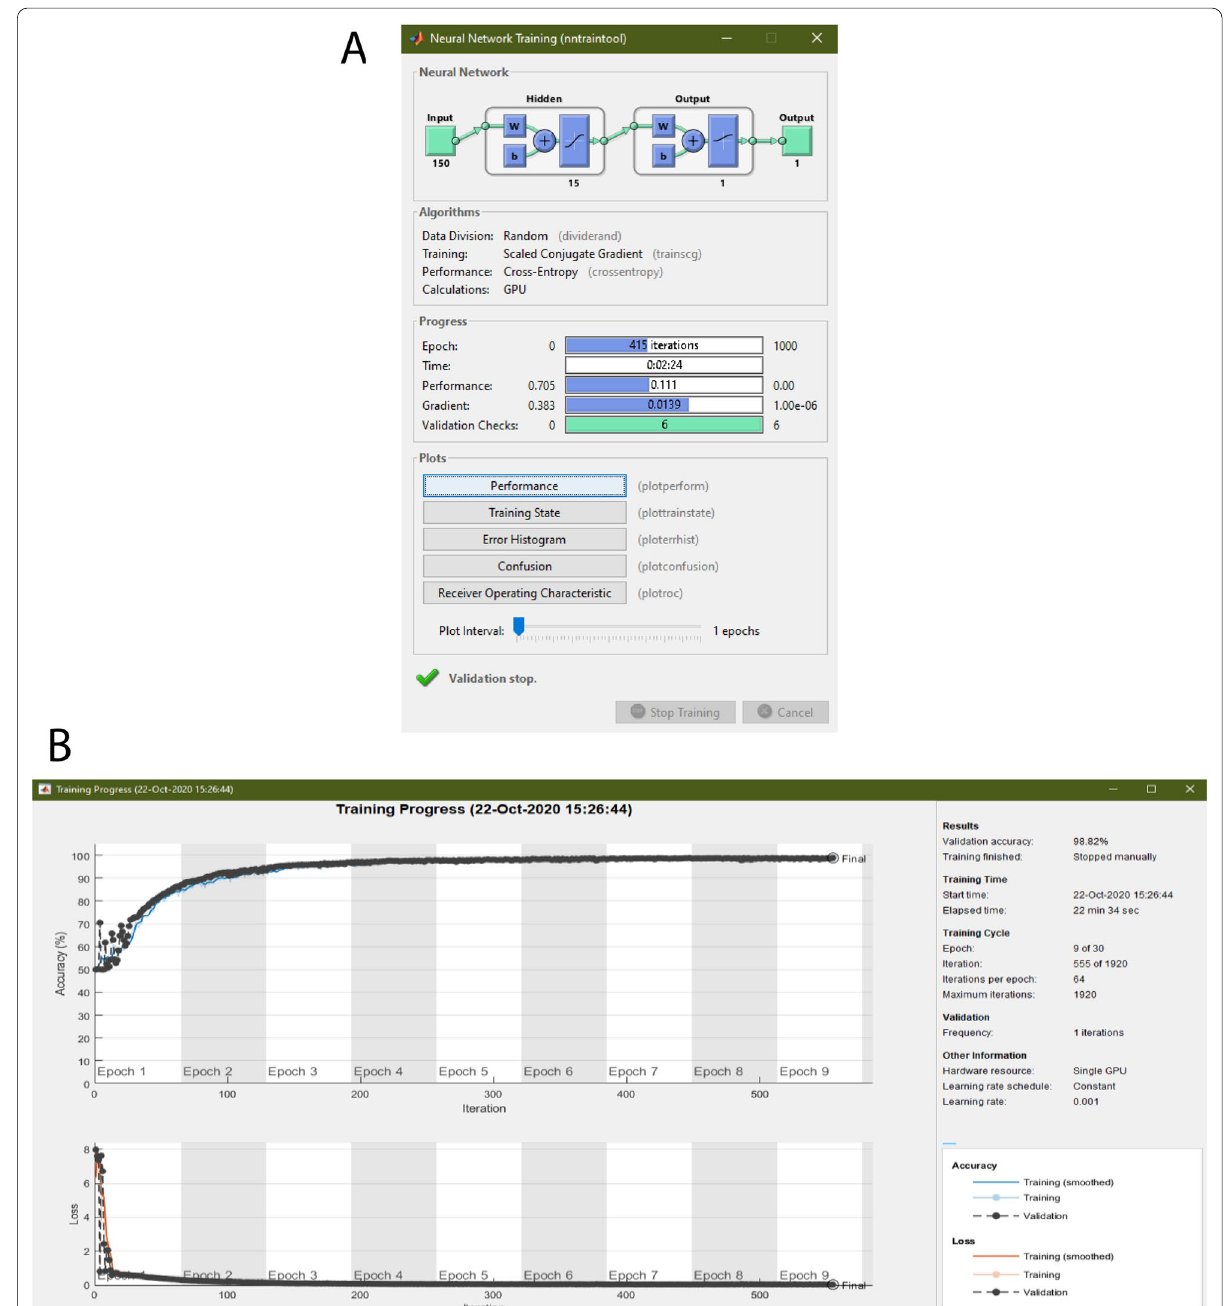
Fig. 10 Screenshots of the toolbox’s network training outputs: multi-layer perceptron training process ( A ) and one dimensional convolutional neural network training process ( B